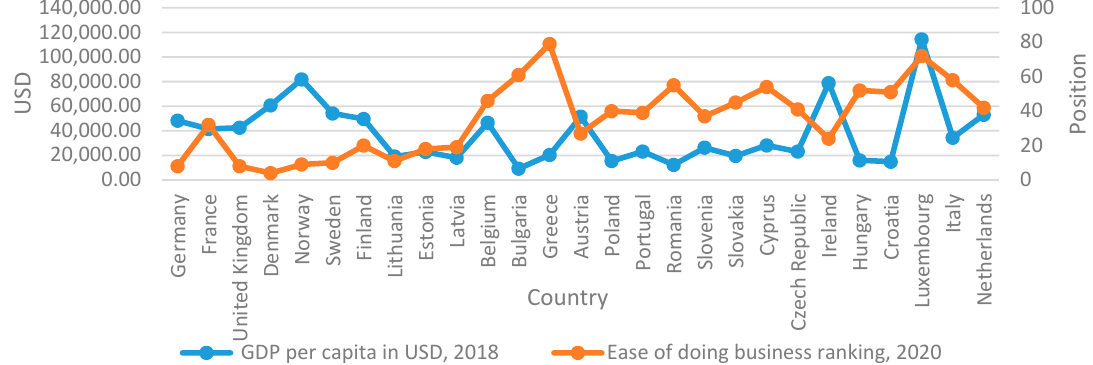
Figure 2. GDP per capita in USD, 2018, and ease of doing business ranking, 2020, values in analysed countries.